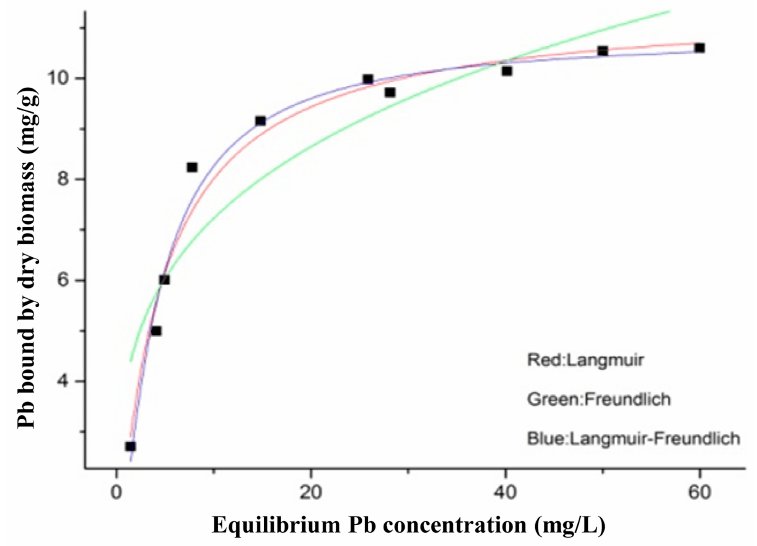
Figure 2. Adsorption isotherm of Pb binding by L. bulgaricus KLDS1.0207.